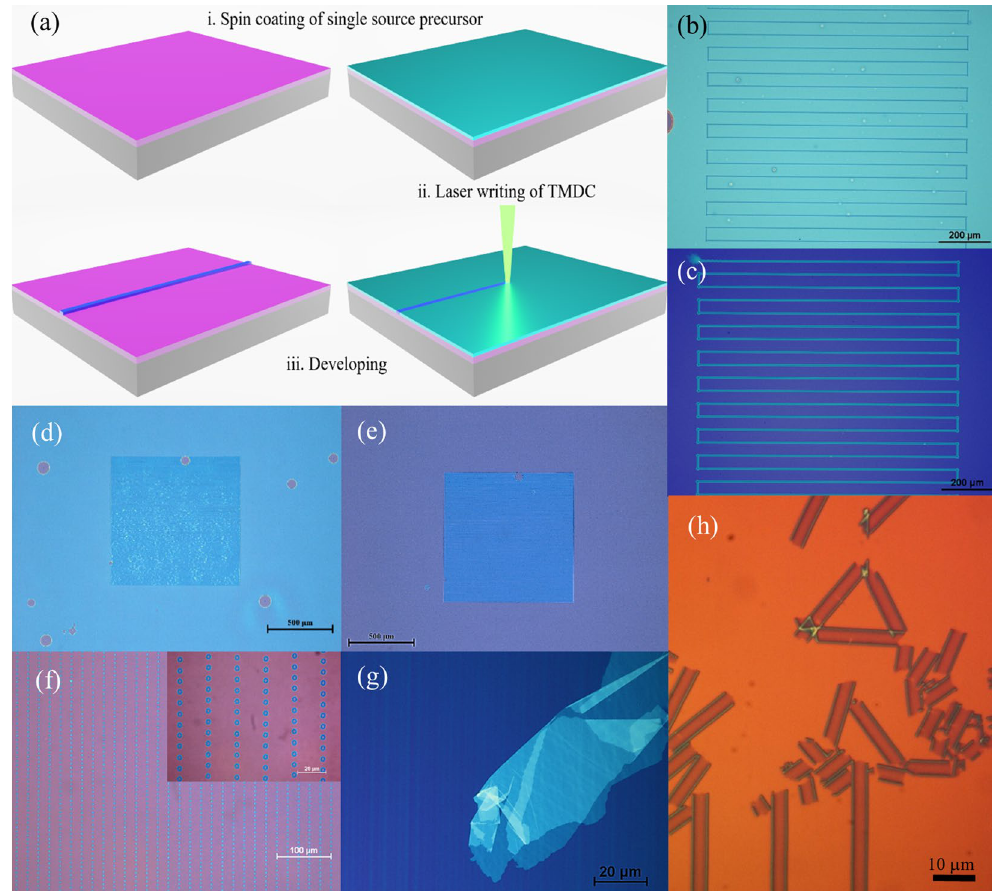
Figure 1. ( a ) Schematic illustration of direct laser printing of 2D-TMDCs, which comprises of: i. spin-coating of the precursor solution, ii. laser irradiation of the precursor and iii. development in organic solvent to remove unexposed precursor film. ( b ) Optical microscopy image of the laser irradiated (NH 4 ) 2 MoS 4 precursor film. The visible serpentine tracks correspond to laser synthesized MoS 2 . ( c ) Optical microscopy image of the pattern shown in ( b ) after “development” step where only the precursor film is preferentially removed leaving behind the MoS 2 pattern. ( d , e ) Optical microscopy image of laser-synthesised MoS 2 film before and after development created by overlapping raster scanning. ( f ) Optical microscopy image of WS 2 micron-size dot array (the inset corresponds to a higher magnification image of the sample). ( g , h ) detached MoS 2 film and tracks due to excessive developing time in DMF